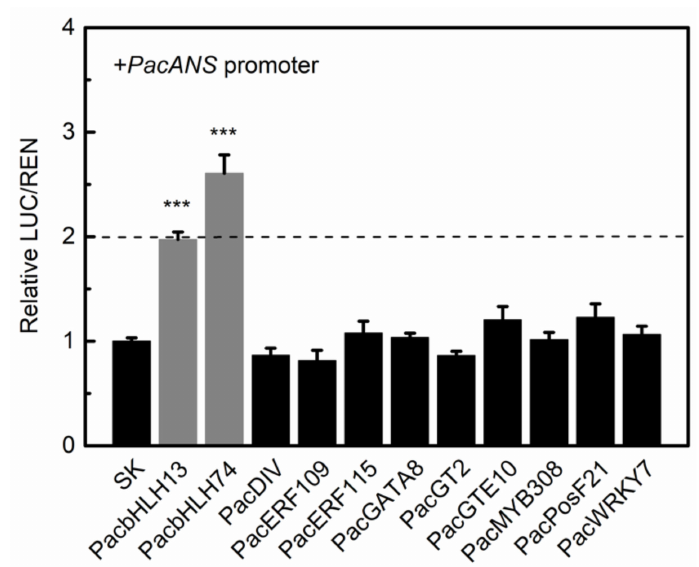
Figure 6. Regulatory effects of TFs on the PacANS promoter, as determined by dual-luciferase assay. The ratio of LUC/REN in the empty vector plus promoter was set as 1. SK refers to the empty pGreen II 0029 62-SK vector. Error bars represent SEs from three replicates. ‘***’ indicate significance levels at p <